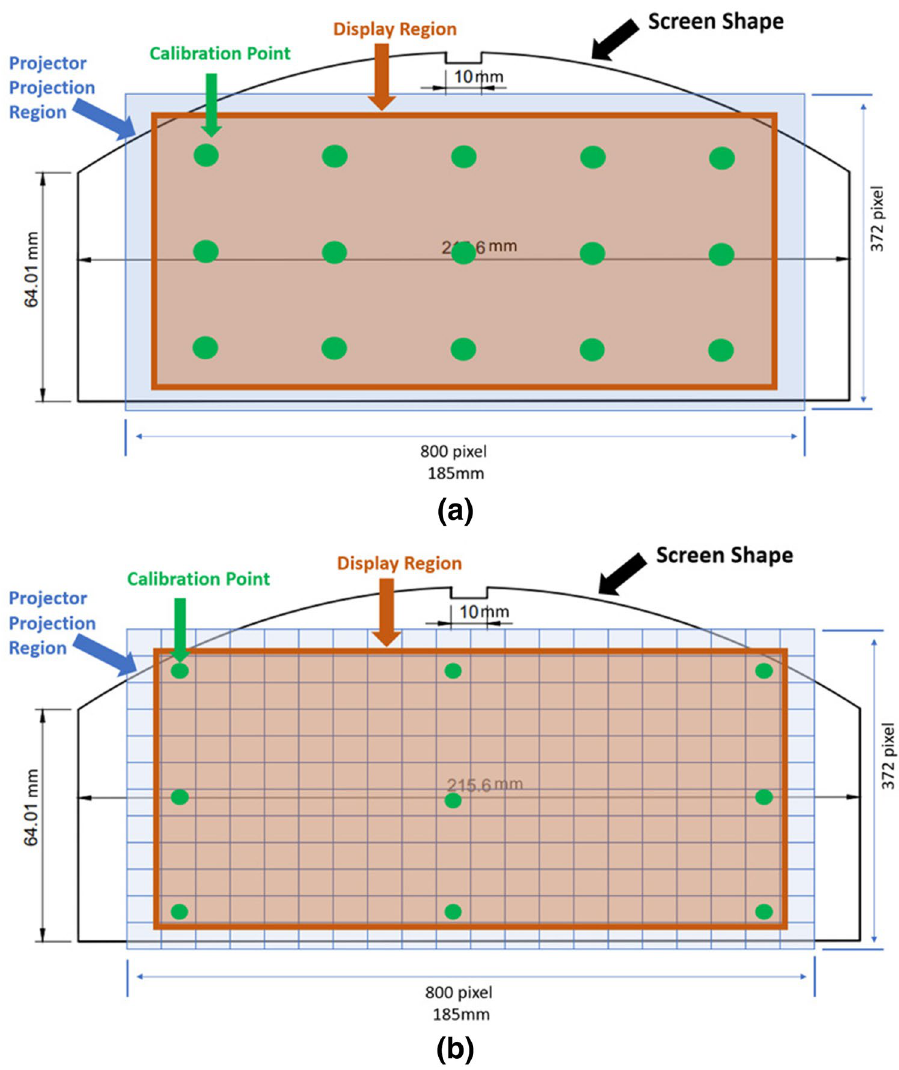
comparison. ( b ) Pattern used for initial system calibration and locations of targets used for accuracy analysis (one target shown at the centre of each rectangle within display